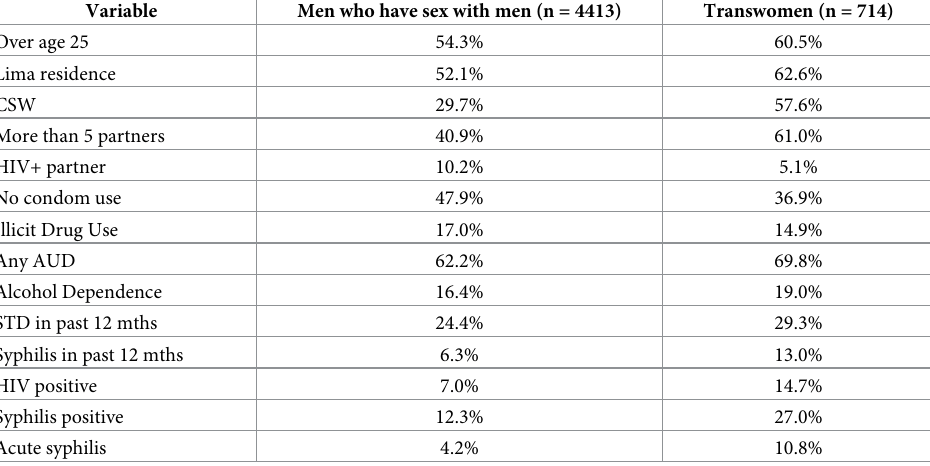
Table 1. Demographics, risk factors, and STI/HIV prevalence by sexual identity: Transwomen versus men who have sex with men (N = 5,127).